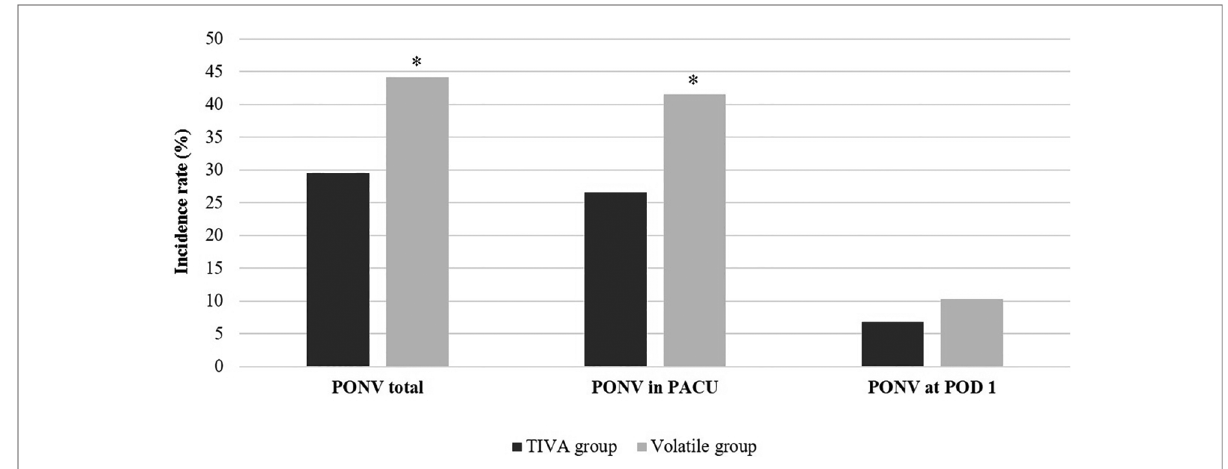
FIGURE 1 Incidence rate of postoperative nausea and vomiting (PONV) between total intravenous anesthesia (TIVA) group and volatile anesthesia group. * P value <0.05 between two groups.